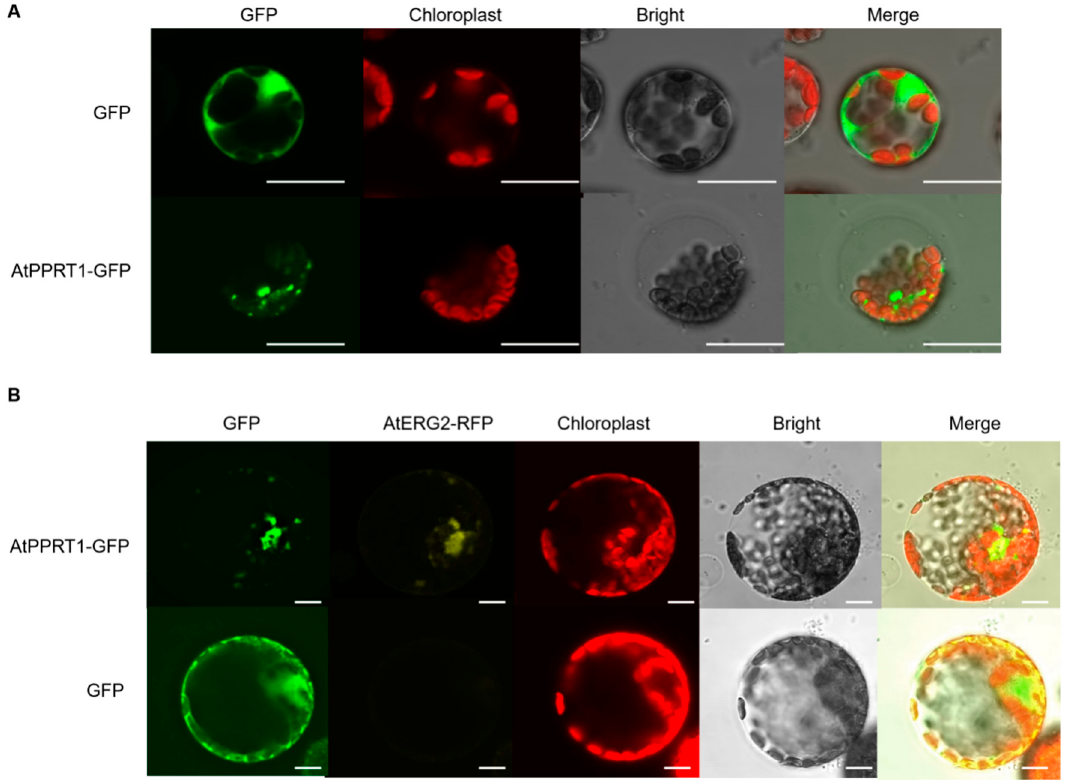
Figure 6. AtPPTR1 is localized in the mitochondria. ( A ) Subcellular localization of AtPPRT1 in Arabidopsis protoplast. The AtPPRT1 coding sequence was cloned into PBI221 containing a CaMV35S promoter for green fluorescence protein (GFP); ( B ) Subcellular localization of AtPPRT1 in tobacco protoplast. The AtPPRT1-GFP and AtERG2-RFP (a mitochondria marker) transiently co-transformed into tobacco protoplast. Auto-fluorescence of chloroplast and bright-field images are also shown for these transgenic cells. All images in this figure were obtained from one optic section. Scale bars are equivalent to 20 μ m.